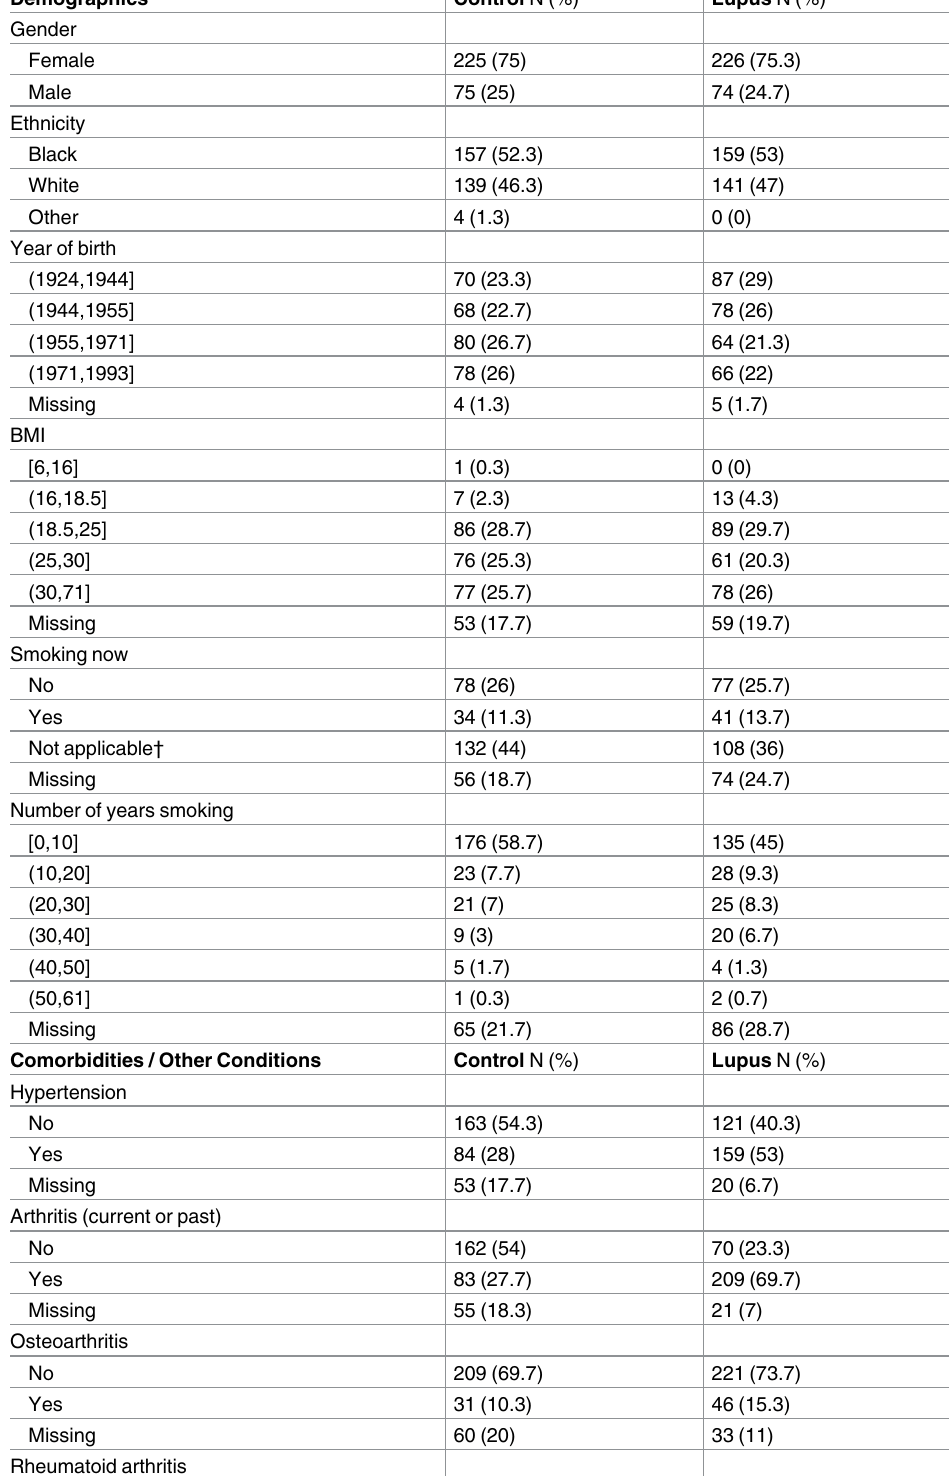
Table 1. Demographics and comorbidities / other conditions by case